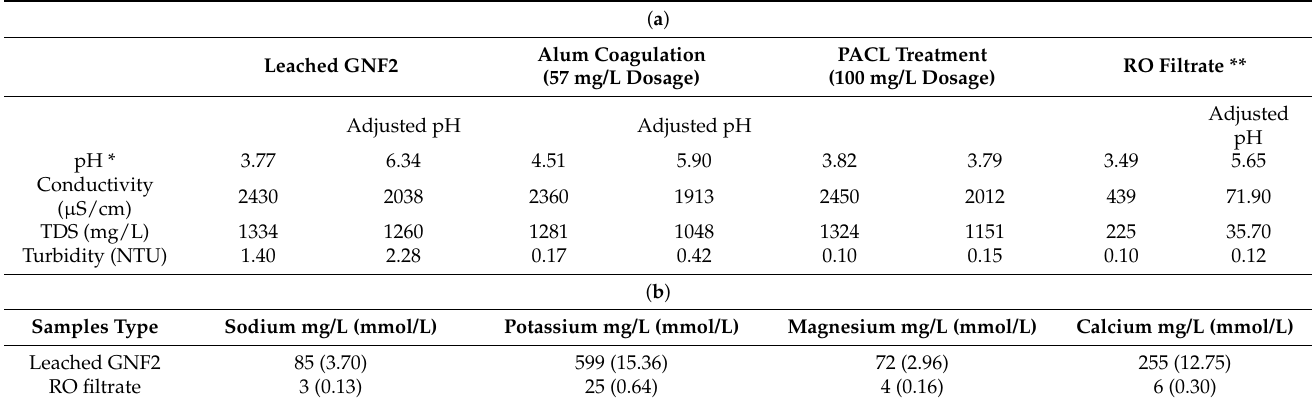
Table 4. ( a ) Analysis of leached and treated GNF2 from GH2. ( b ) Metals analysis of leached and treated GNF2 from